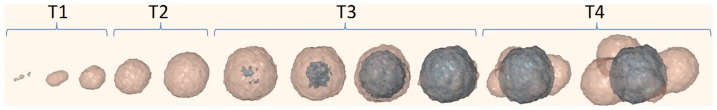
Tumor volume and morphology changes during progression including exponential growth, linear expansion, stasis, and secondary growth processes (T1–T4).Brown region: Viable cells; Black region: Necrotic cells.